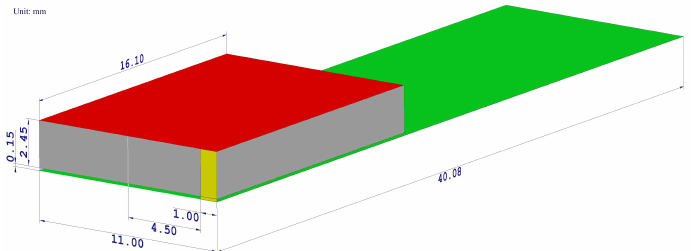
Figure 2. The geometrical layout of a designed PIFA antenna model. The radiating element is highlighted by the red color, the ground plane by the green color, the shorting plate by the yellow color, the feeding pin by the blue color, and the air gap by the gray color. All dimensions are shown in millimeters.